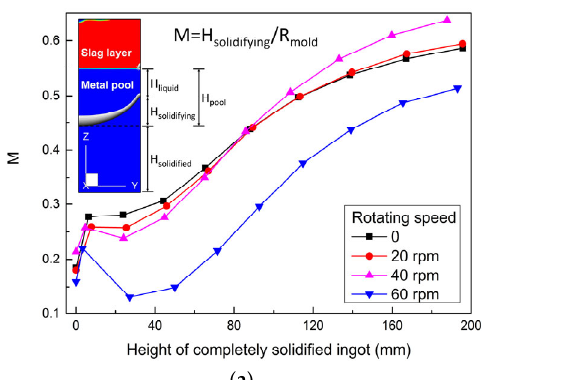
Figure 7. Time variation of maximum temperature of the melt with the electrode rotating at different speeds.